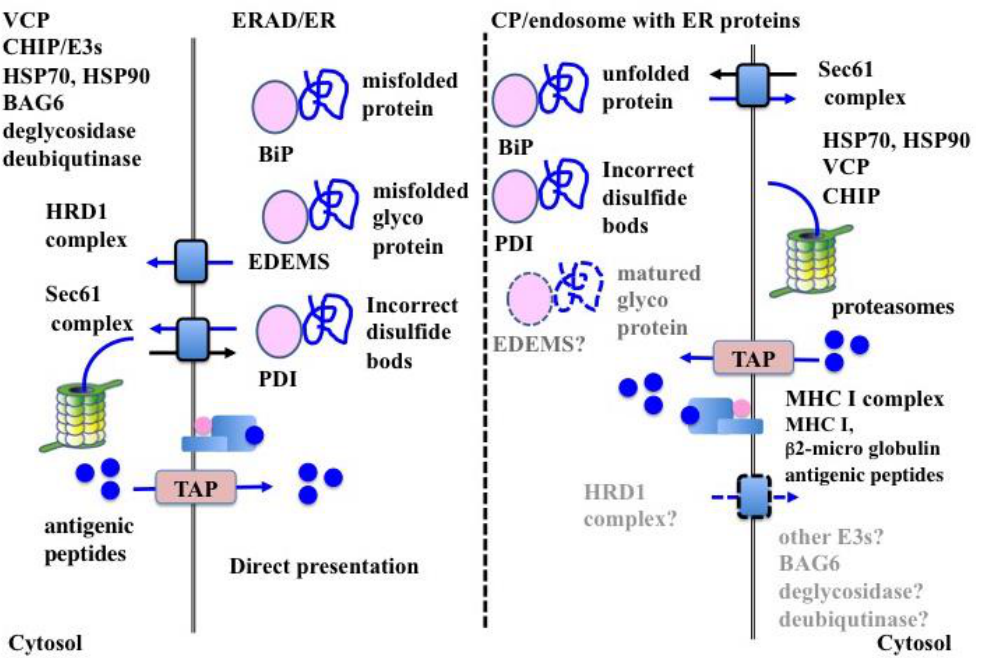
Figure 2. The molecular mechanisms of endoplasmic reticulum-associated degradation (ERAD) and cross-presentation (CP). The processing of exogenous proteins in CP involves a part of the molecular machinery of ERAD; however, significant differences exist. ERAD is carried out in the ER, while ERAD-dependent antigen processing during CP takes place in the non-classical endosomes, together with ER-resident molecules. The recognition of unfolded proteins by ER-resident molecules is similar in both processes, except for the EDEMs. Both the HRD1 and the Sec61 complexes are utilized in ERAD, but the HRD1 complex is not essential for CP. Additionally, several kinds of ERAD-related molecules, such as E3s, cofactors of VCP (i.e., NPL4 and UFD1), co-chaperones of Hsp70 (i.e., Bag6), deglycosidase, and deubiquitinase, play an important role in ERAD but are not investigated in CP. Solid arrows indicate mechanisms supported by experimental evidence. Dashed arrows indicate hypothetical mechanisms that still lack experimental evidence.